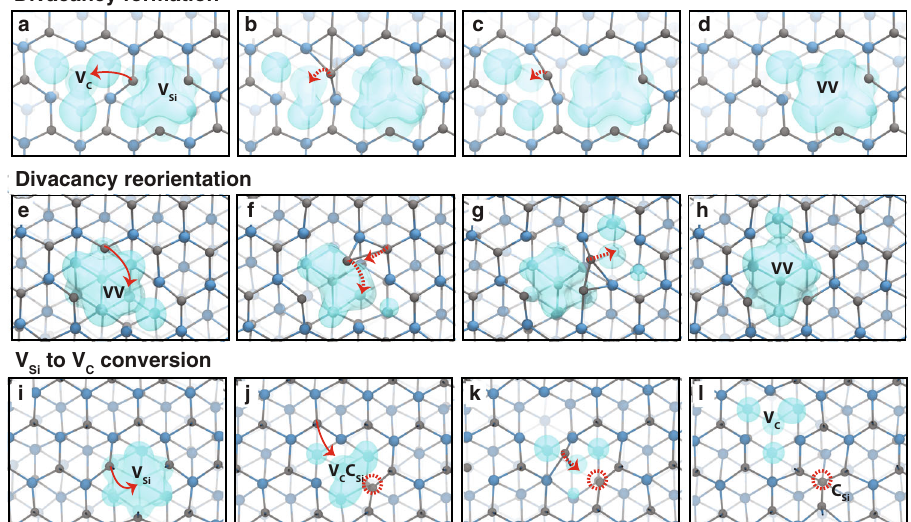
Fig. 2 Dynamics of vacancy formation and migration from classical molecular dynamics (MD) simulations. A series of snapshots from classical MD simulations at temperatures above 1000 K show the mechanisms for a – d , the divacancy formation, e – h , divacancy reorientation, and i – l , conversion from a V Si to a V C before the V Si encounters an existing V C . Three-dimensional vacancy volumes colored in teal blue show the location, size, and shape of void volumes at the defect site. a A carbon atom in-between the V C and V Si sites displaces the V C and forms a VV, following the path marked by a red arrow. b , c During intermediate steps, the mobile carbon atom interacts with neighboring atoms as the local coordination changes from fi ve- and threefold. d The divacancy consists of a carbon vacancy adjacent to a silicon vacancy. e The orientation of VV changes as a carbon atom adjacent to V Si migrates to the V C site. f , g C – C bonds are formed and broken during intermediate steps. h The V Si – V C axis in the fi nal VV con fi guration is rotated compared to that in the initial con fi guration, within the laboratory frame. i, j V Si converts into C Si V C as a nearest-neighbor carbon atom displaces it. Red circle indicates the C Si site. k , l C Si V C dissociates into V C and C Si as V C exchanges position with a nearest carbon